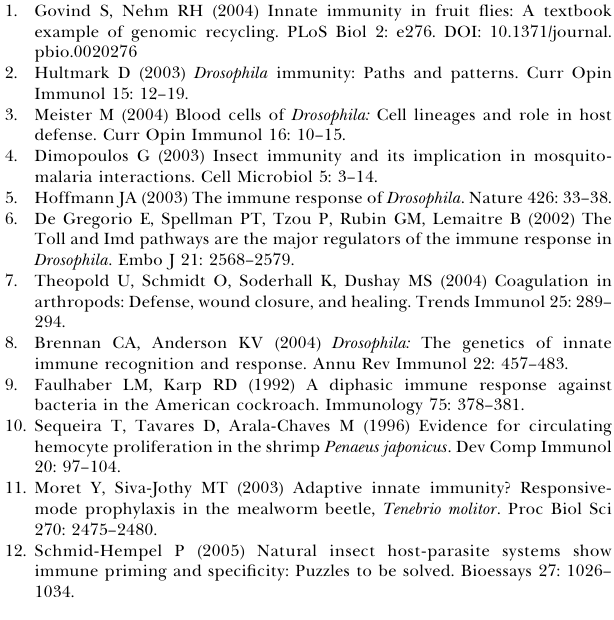
Figure S2. AgDscam Gene Organization